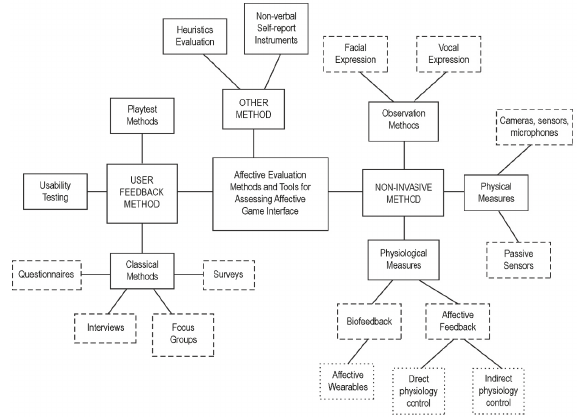
Figure 1: Affective evaluation methods and instruments for assess- ing affective game